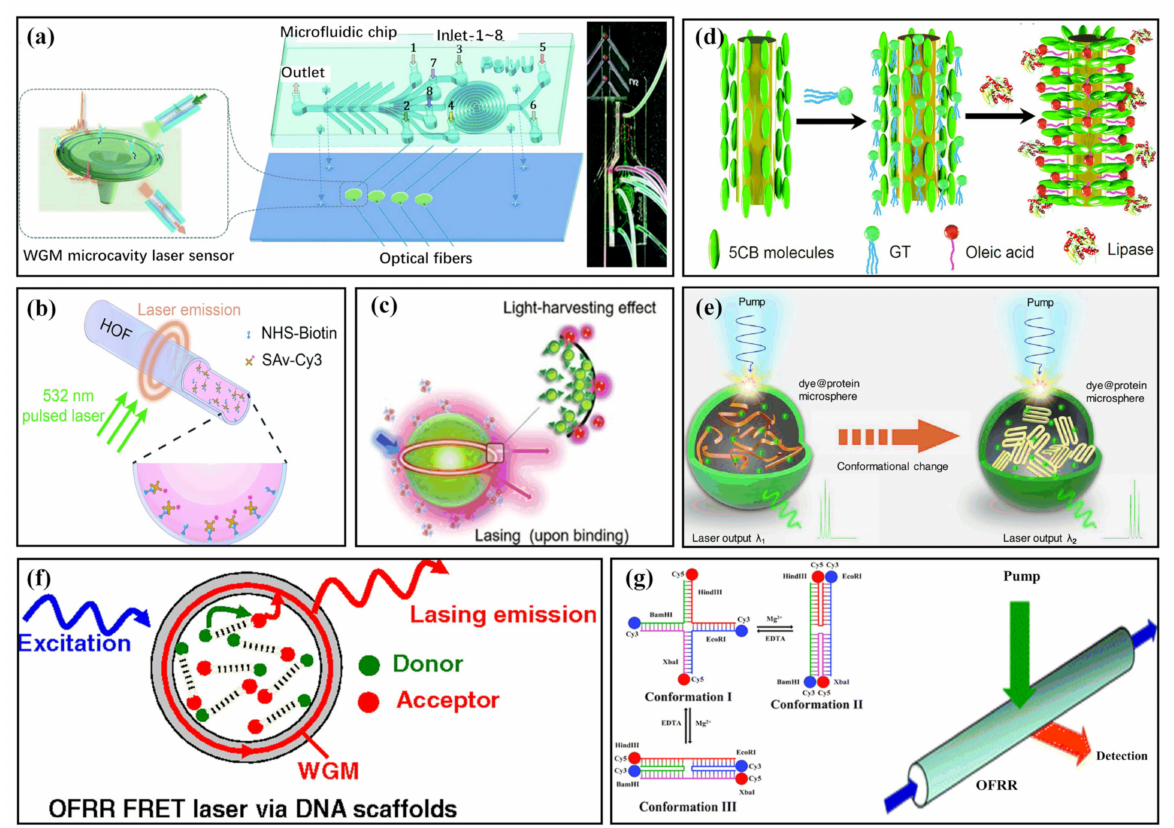
Figure 3. Protein, protein appendage, and DNA detection with biolasers. ( a ) Diagram of the WGM microlaser optofluidic biochip for ELISA and photo of the fabricated optofluidic chip. (Adapted with permission from [47]. Copyright 2020 The Royal Society of Chemistry.) ( b ) Schematic of the sequentially bioconjugated fiber optofluidic laser (FOFL). (Adapted with permission from [41]. Copyright 2021 The Royal Society of Chemistry.) ( c ) Illustration of interfacial FRET laser. (Adapted with permission from [42]. Copyright 2020 WILEY-VCH Verlag GmbH & Co. KGaA, Weinheim.) ( d ) Diagram of the molecular orientation of LC 5CB before and after the enzymatic reaction of lipase and glycerol trioleate. (Adapted with permission from [53]. Copyright 2020 The Royal Society of Chemistry.) ( e ) Illustration of the principle of biolasers based on silk protein conformation sensing before and after treatment with methanol. (Adapted with permission from [54]. Copyright 2021 American Chemical Society.) ( f ) Conceptual illustration of optofluidic ring resonator (OFRR) FRET lasing fabricated using DNA scaffolds. (Adapted with permission from [44]. Copyright 2010 Proceedings of the National Academy of Sciences of the United States of America.) ( g ) Left: The ion-dependent folding of the DNA Holliday junction with and without Mg 2+ . Right: Schematic of the OFRR bio-switchable lasing. (Adapted with permission from [49]. Copyright 2012 The Royal Society of